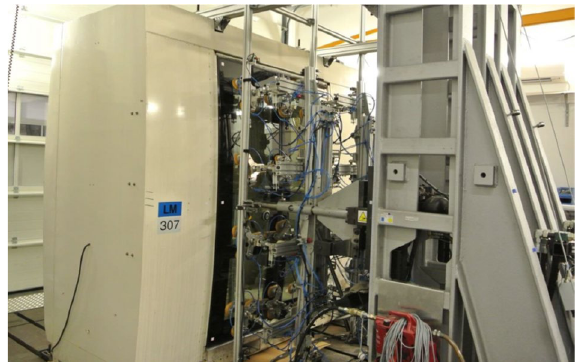
Figure 22. Real loading (dynamic) on the testing